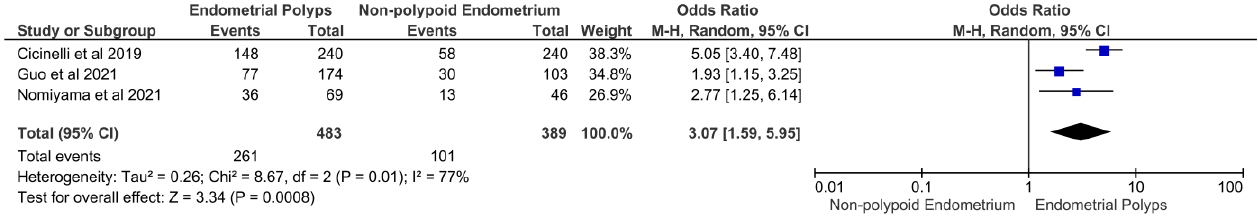
Figure 4. Forest plot. Women with endometrial polyps versus women with a non-polypoid endometrium: prevalence of chronic endometritis.